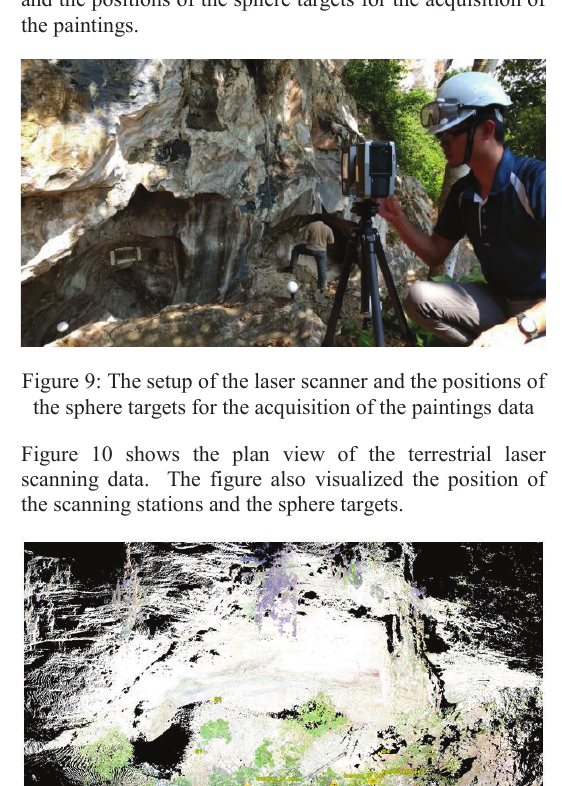
Figure 12: The visualization of terrestrial laser scanning (a) and (c), and the UAV-based close-range photogrammetry (b) and (d)